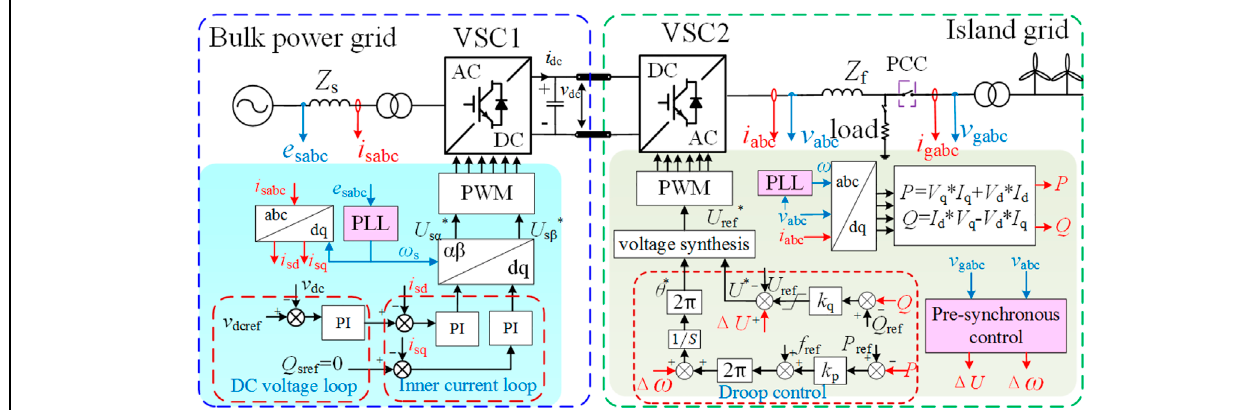
FIGURE 1 | Structural model of the maritime VSC-HVDC system.